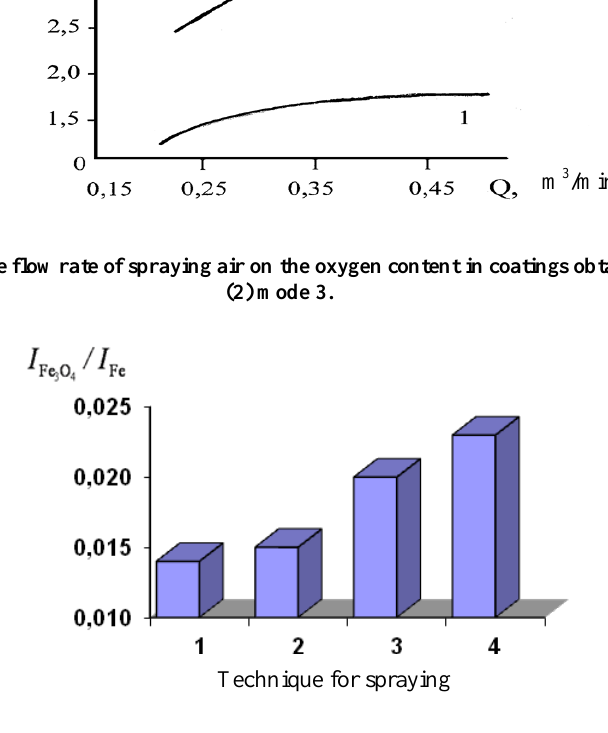
Technique for Fig. 4. The relative content of Fe 3 O 4 in coatings obtained using: (1) gas flame; (2) activated EAS in a reducing atmosphere; (3) activated EAS in an oxidizing atmosphere; (4) spraying with air.